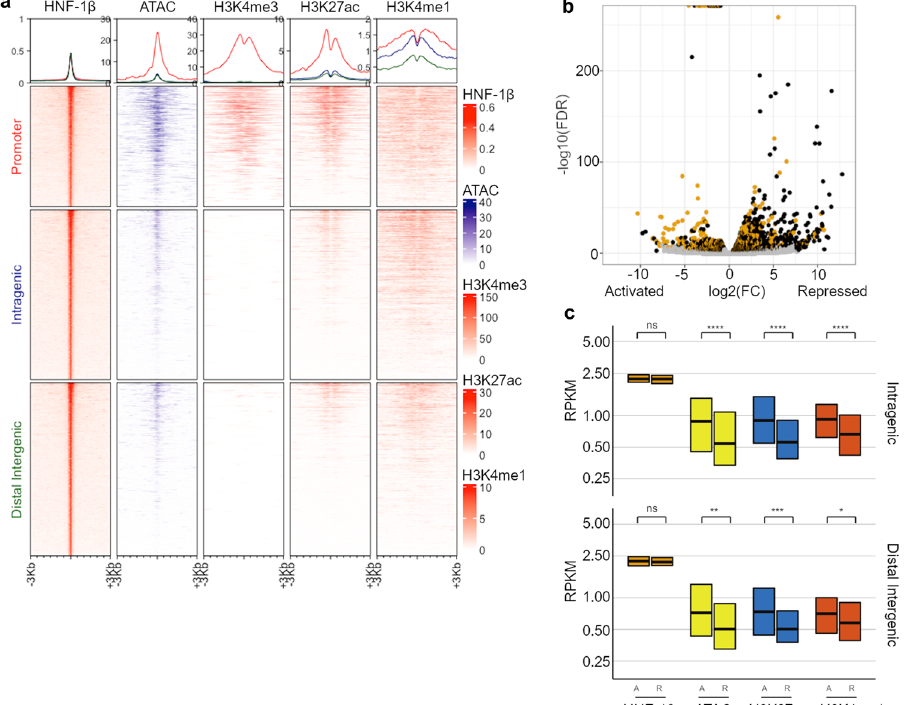
Figure 2. Genome-wide analysis of open chromatin and histone modifications at HNF-1β binding sites in developing mouse kidneys. ( a ) Enrichment of ATAC-seq, H3K4 trimethylation (H3K4me3), H3K27 acetylation (H3K27ac), and H3K4 monomethylation (H3K4me1) at HNF-1β binding sites in chromatin from E14.5 kidney. Enrichment is shown in the promoter (upper panel), intragenic (middle panel), and distal intergenic regions (lower panel). Peaks are centered on HNF-1β binding sites (left panels). Top panel shows total binding in the promoter (red line), intragenic (blue line), and distal intergenic regions (green line). ( b ) Volcano plot of RNA- seq results showing genes that are activated or repressed in purified UB cells from heterozygous control E14.5 kidneys compared to HNF-1β mutant kidneys. Gold circles indicate differentially expressed genes that contain nearby HNF-1β binding peaks. ( c ) Comparison of HNF-1β binding, ATAC-seq signal, H3K27ac, and H3K4me1 in genes that are directly activated (A) or repressed (R) by HNF-1β. Binding in intragenic (upper panel) and distal intergenic regions (lower panel) is shown. Normalized enrichment values are shown as reads per kilobase of transcript (RPKM). Boxplots indicate the median and interquartile range. Asterisks indicate statistically significant differences using the Wilcoxon test (*p < 0.05; **p ≤ 0.01; ***p ≤ 0.001; ****p ≤ 0.0001; ns, p ≥ 0.05). Median and mean enrichment values and individual Wilcoxon test results can be found in